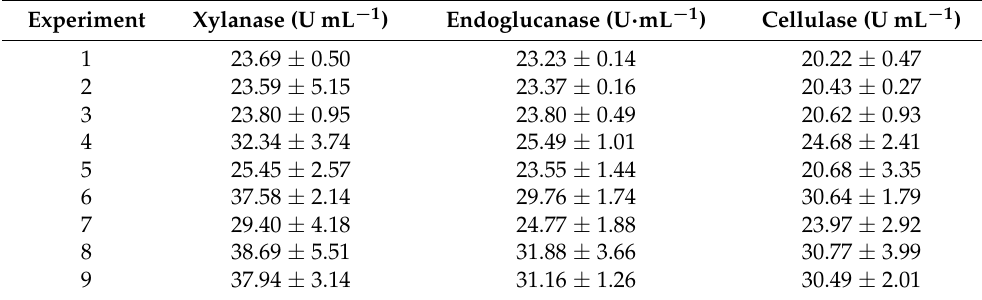
Table 3. Experimental results on the enzymatic activity of the biofilm culture supernatant after 120 h of growth.